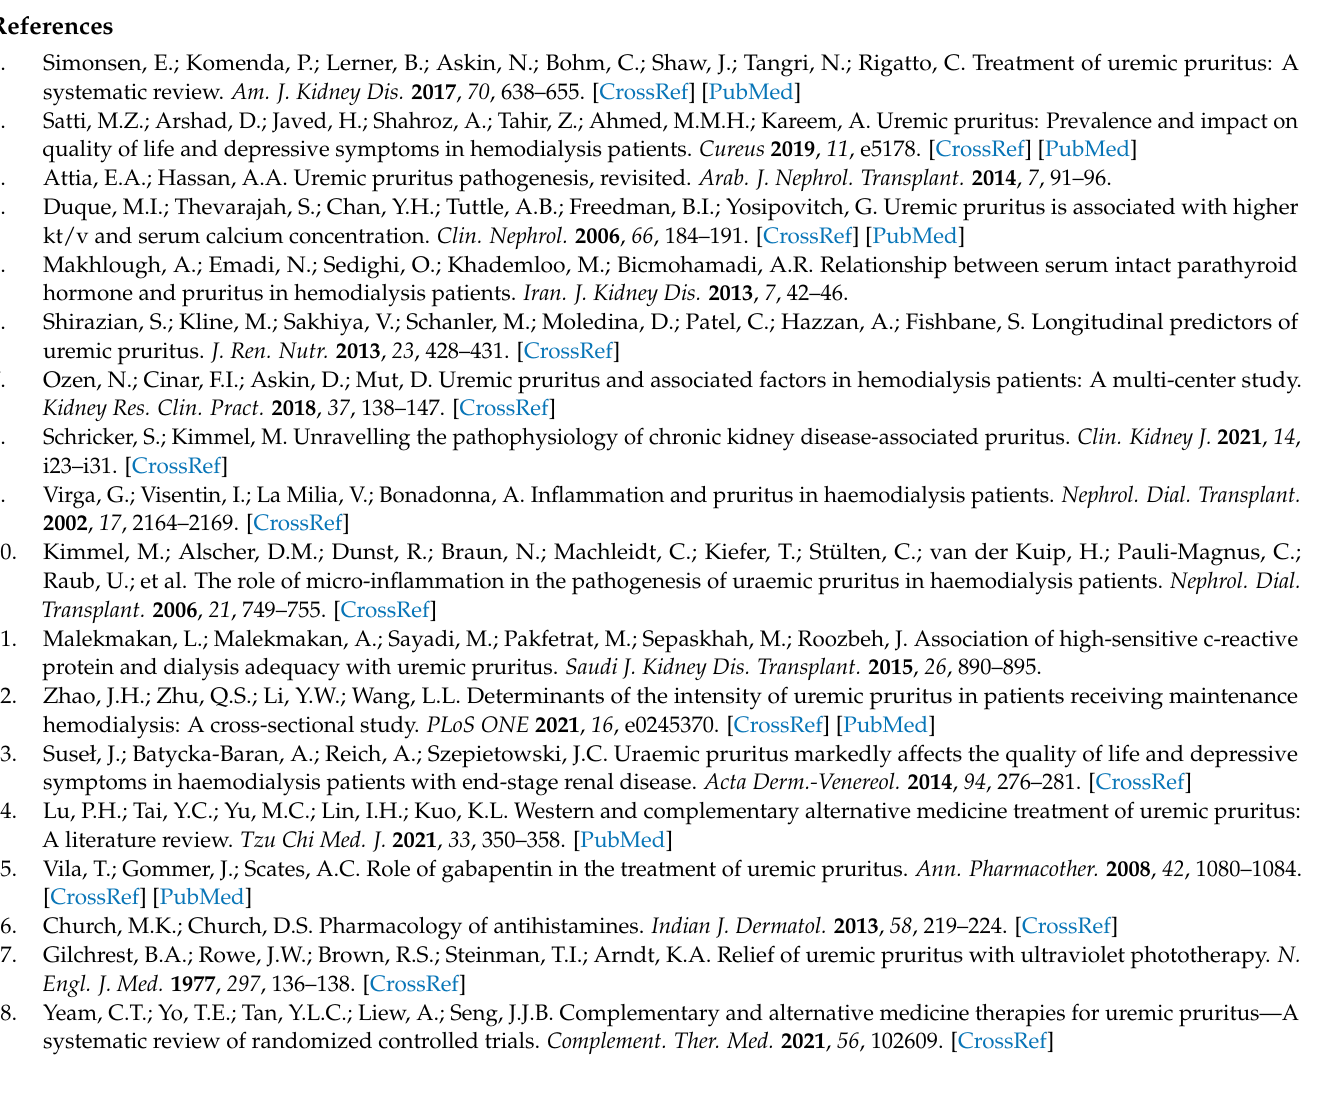
medicine; Table S1. Laboratory data for selected studies; Table S2. Components of Chinese herbal medicine in the included studies; Table S3. Grade profile summary of ‘Chinese Herbal Medicine for uremic pruritus’ Quality assessment; Table S4. Search